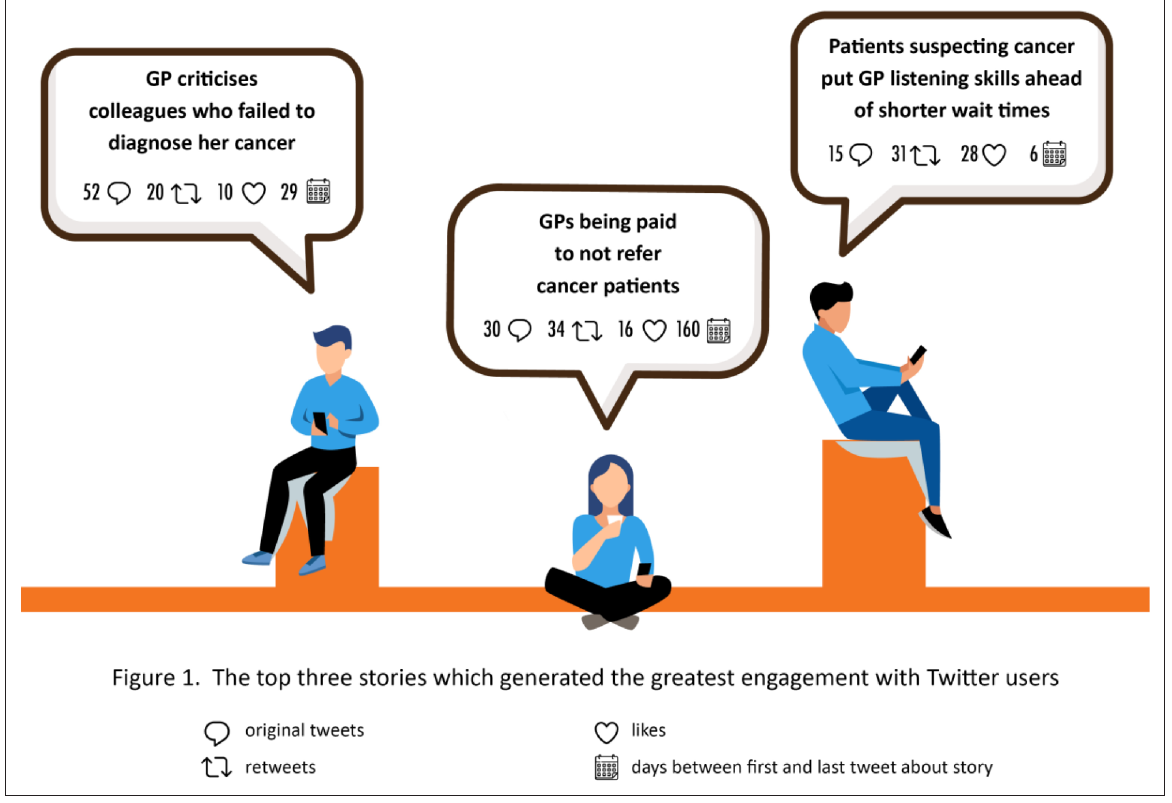
Figure 3 Top three stories that generated the greatest engagement with Twitter